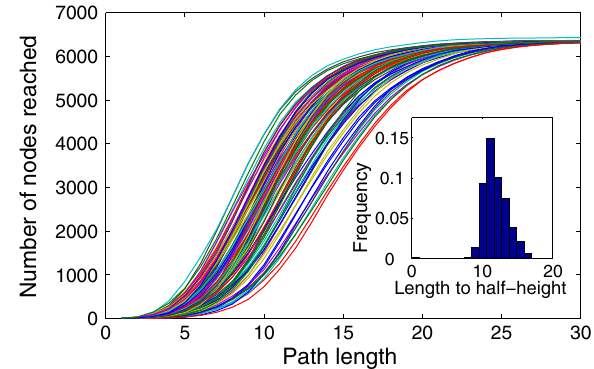
FIG. 2. Definitional iteration of words in the dictionary. Using a random sample of 100 words, the number of unique nodes that could be reached within the given directed distance of each node is recorded. Nearly all starting points lead to a strongly con- nected component of 6296 words labeled as the core.